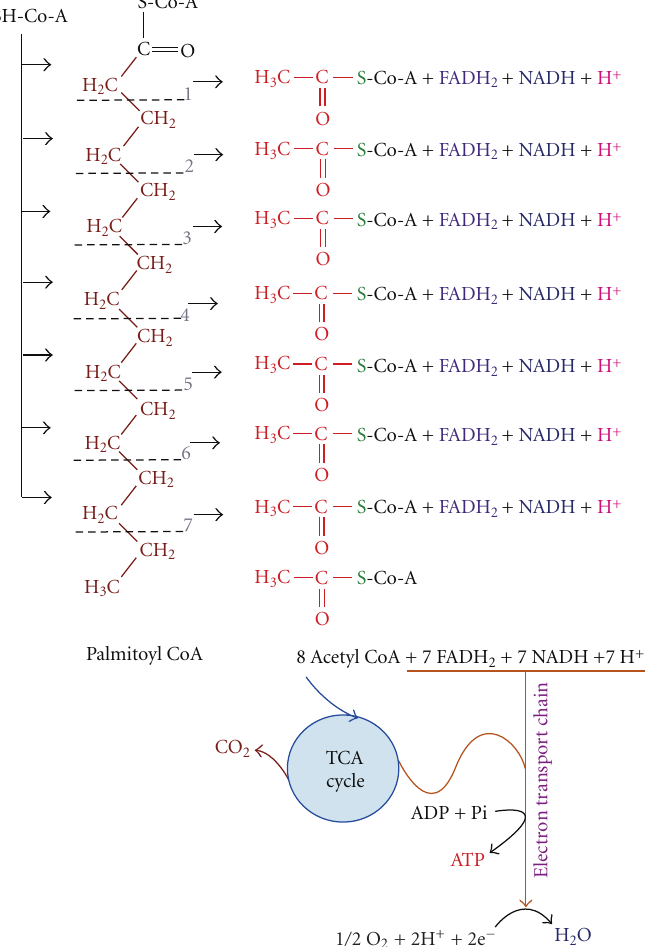
Figure 14: The sequential degrading of fatty acyl CoA molecules, as occurs in the β -oxidation pathway, within the mitochondria.